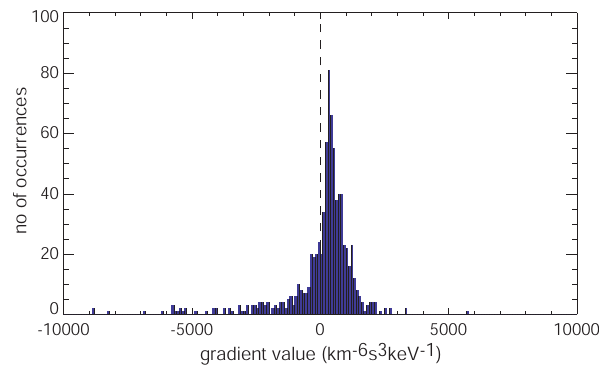
Fig. 5. Distribution of the gradient magnitude measured between ∼ 2keV and 12keV for all IDFs measured between 09:00 and 16:00 MLT.